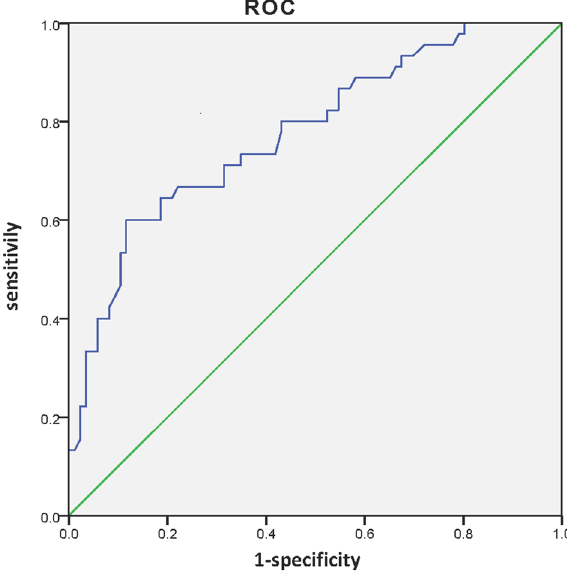
Figure 3. ROC curve in the validation cohort. The AUC was 0.777 (95% CI